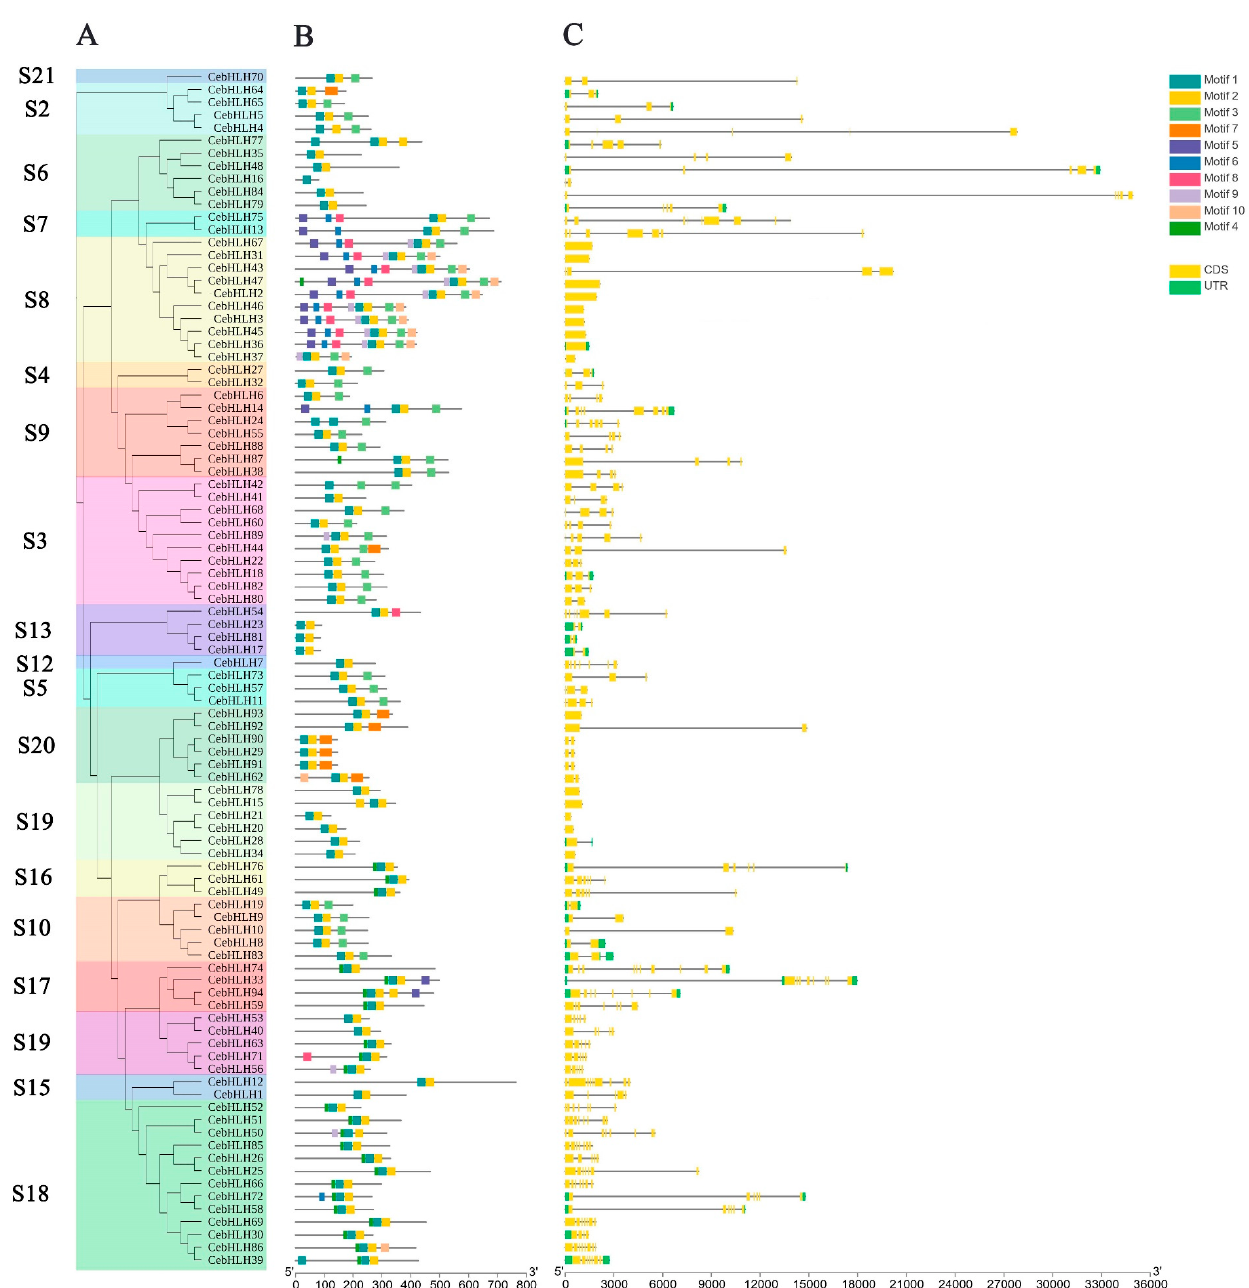
Figure 2. Gene structure and conserved motifs of CebHLHs. ( A ) The phylogenetic tree containing 94 CebHLHs. ( B ) Conserved motifs of CebHLHs represented by squares of different colors. ( C ) Intron–exon structure of CebHLHs . The x-axis in B is the number of amino acids (aa), and the x-axis in C is the number of base pairs (bp).